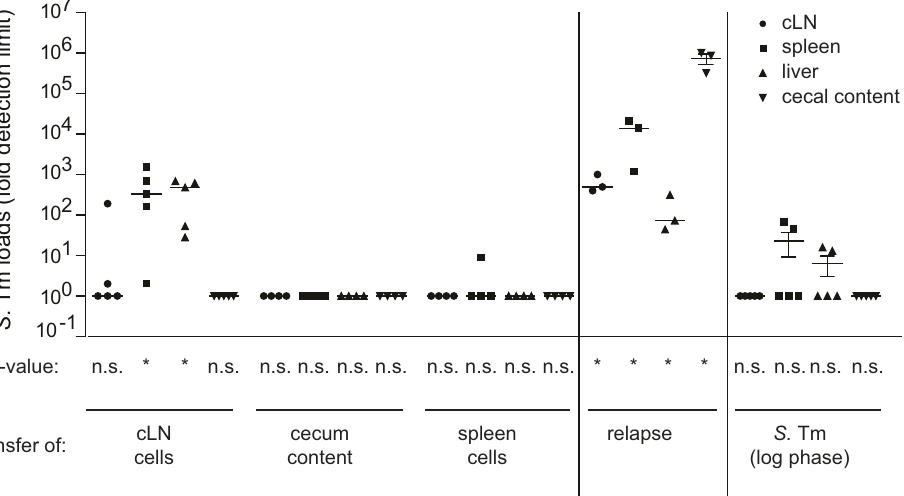
Figure 2. S. Tm in cLN from ciprofloxacin-treated mice are sufficient for initiating an infection. C57BL/6 mice were infected for 1 d with S. Tm before ciprofloxacin therapy was started (2 6 62 mg/kg/d by gavage). Recipient mice remained uninfected and were also treated with ciprofloxacin. (Left) 3 d p.i. mice were sacrificed and single-cell suspensions of the cLN or spleen or cecal content were transferred into antibiotic- treated naı¨ve recipient mice. Four days later, recipient mice were sacrificed and pathogen loads in the respective organs were determined. Transfer of cLN cells leads to significantly higher infection rates compared to transferred spleen cells, cecum content, or S. Tm cultured in LB (right part; Fisher’s exact test, p =0.00482). (Middle) Relapse control. Mice were infected for 1 d with S. Tm, treated with ciprofloxacin for 2 d, and left untreated for 4 additional days. Then, we analyzed pathogen loads in the cecum content, cLN, spleen, and liver.